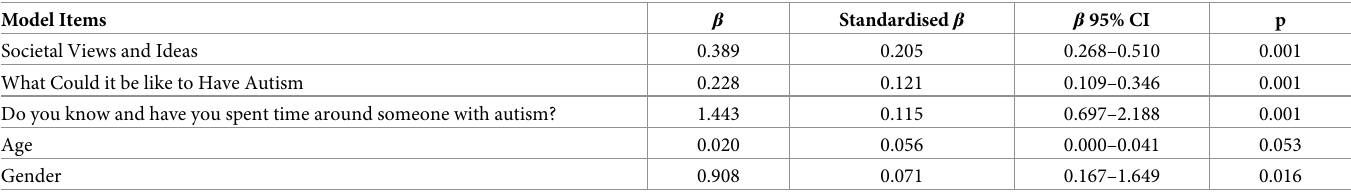
Table 9. Backward multiple linear regression statistics—knowledge section